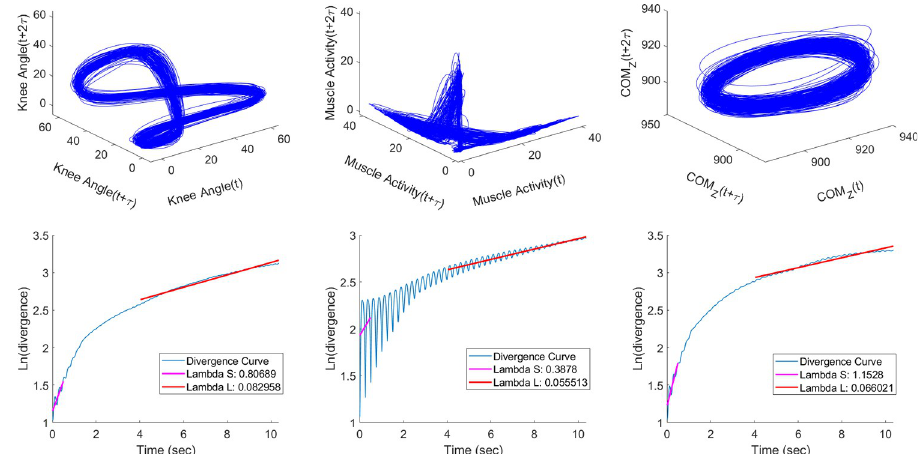
Fig 1. Schematic representation of the estimation of the maximum finite-time Lyapunov exponent for the knee sagittal plane (left), rectus femoris activities (centre) and COM trajectories (right). The 3D reconstruction of the phase- space and the expanded view of the reconstructed phase-space (up), and the average logarithmic rate of divergence for λ S and λ L